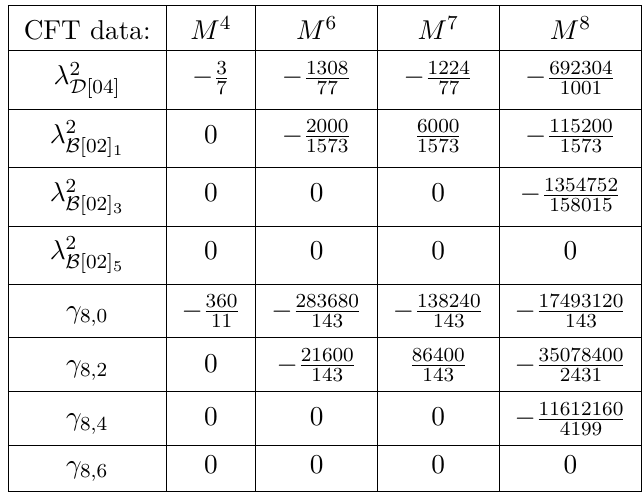
Table 2 . Contributions to the OPE coefficients squared λ 2 of some short multiplets D [04] and 22 M B [02] ‘ for odd ‘ that are not in the 2d chiral algebra sector, as well as to the anomalous dimensions γ 8 ,‘ for even ‘ of the lowest twist t = 8 unprotected multiplet L [00] , from large s, t degree a − 7 contact Mellin amplitudes M a ( s, t ) . Adapted from [35], with typos